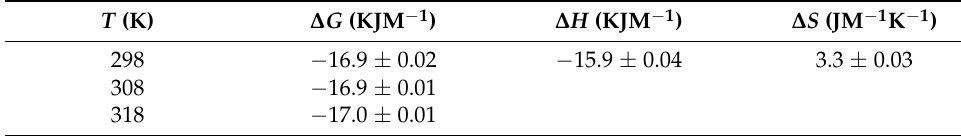
Table 4. Thermodynamic parameters of HSA–cuminol